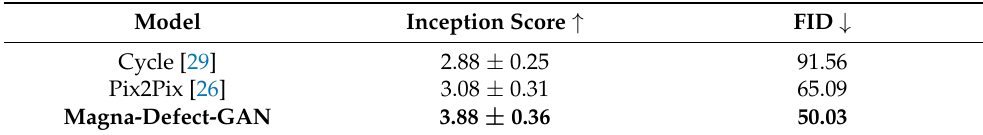
Table 1. Performance of the Magna-Defect-GAN